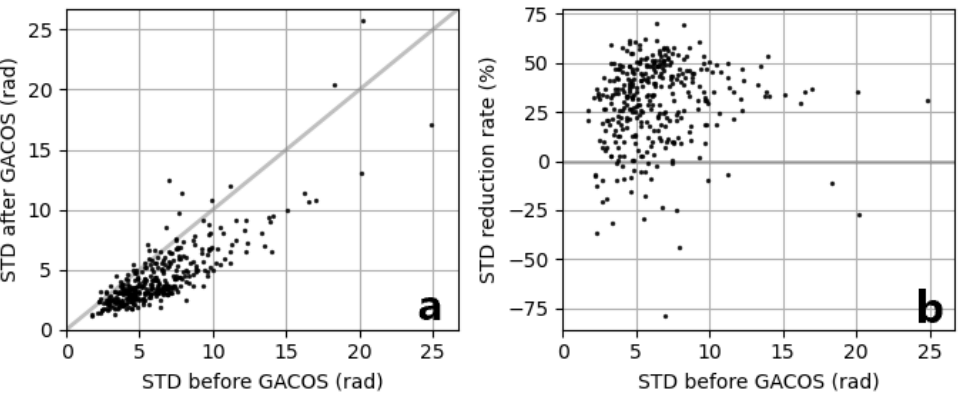
Figure 2. Correlation diagram showing standard deviation: ( a ), of unwrapped phases before and after the GACOS corrections and their reduction rates; ( b ), for ascending track 175. The gray line denotes a 1:1. The reduction of STD for the ascending orbit is moderate. The STD decreased from 6.35 rad to 4.41 rad on average with a mean reduction rate 29.57%.